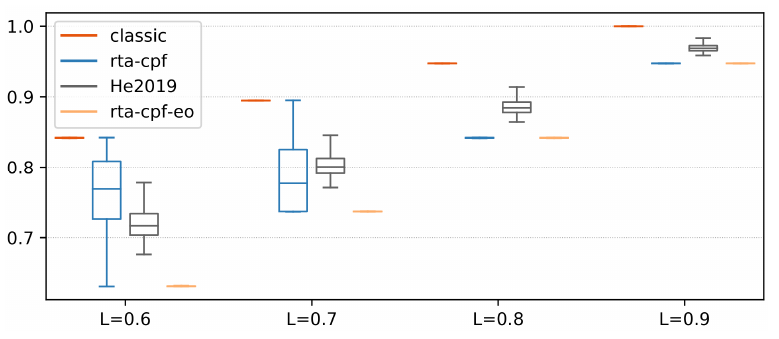
Figure 8. Sensitivity of CP ratio ( m = 4, p = 8).